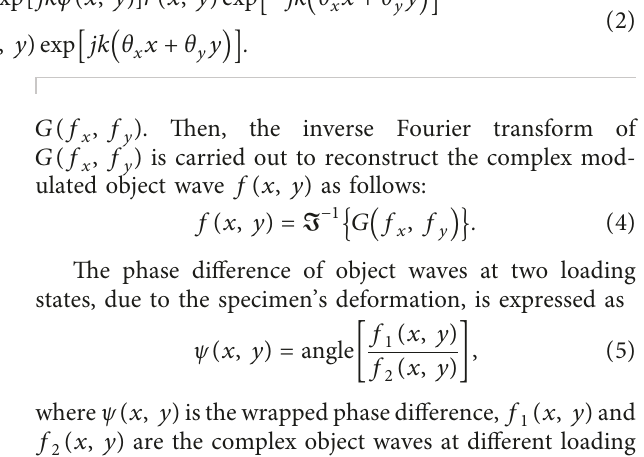
Figure 1: Principle diagram of the digital holographic system. BS and BS 2 are the beam splitters; M 1 and M 2 are the mirrors; L 1 , L 2 , L 3 , and L 4 are the positive lenses; CL is the negative lens; SF 1 and SF 2 are the spatial